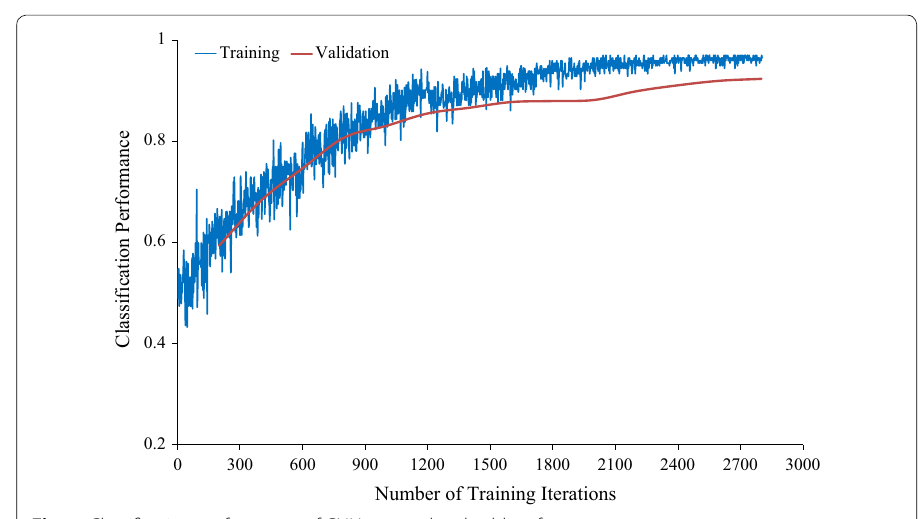
Fig. 5 Classification performance of CNN on word embedding feature vectors